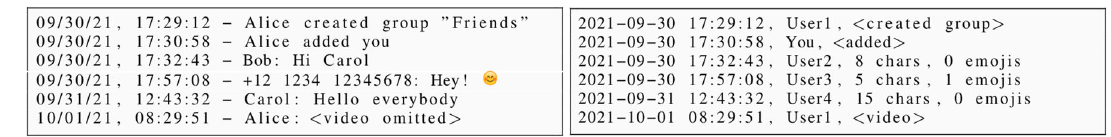
Fig. 1 Screenshot of a chat history as exported by WhatsApp (left), and its corresponding anonymized and normalized version (right). In the anonymization process, user names as well as the content of the message is removed and only relevant information about the communication behavior is kept, like, for example, the message type or the number of characters and emojis.